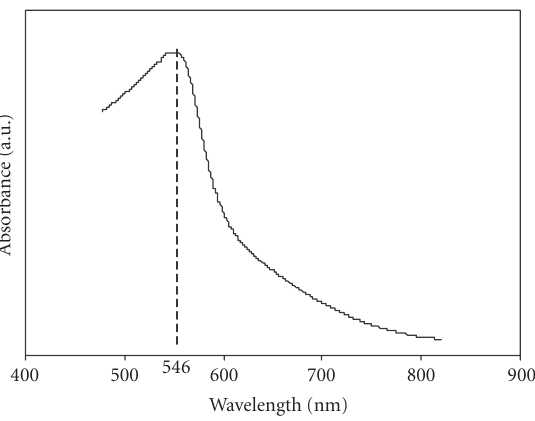
Figure 4: Absorbance curve for Zn-dotted α -Fe 2 O 3 (sample E).